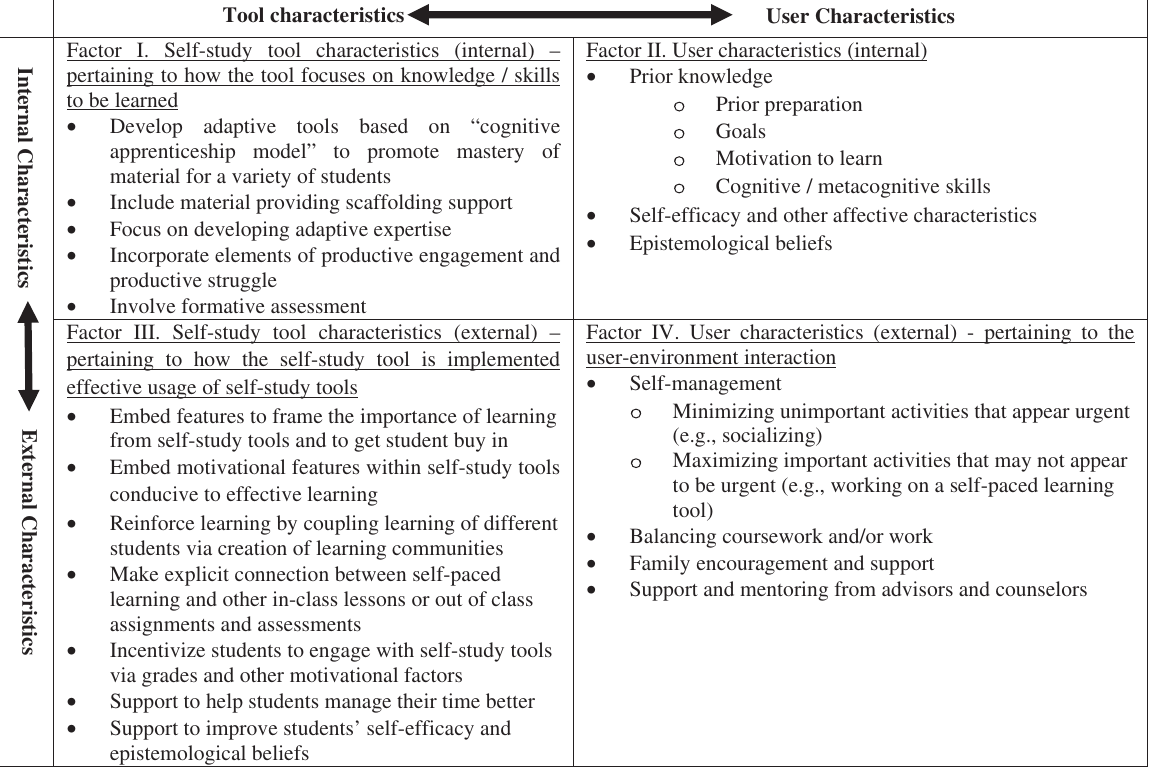
FIG. 3. Self-study for Engaged Learning Framework